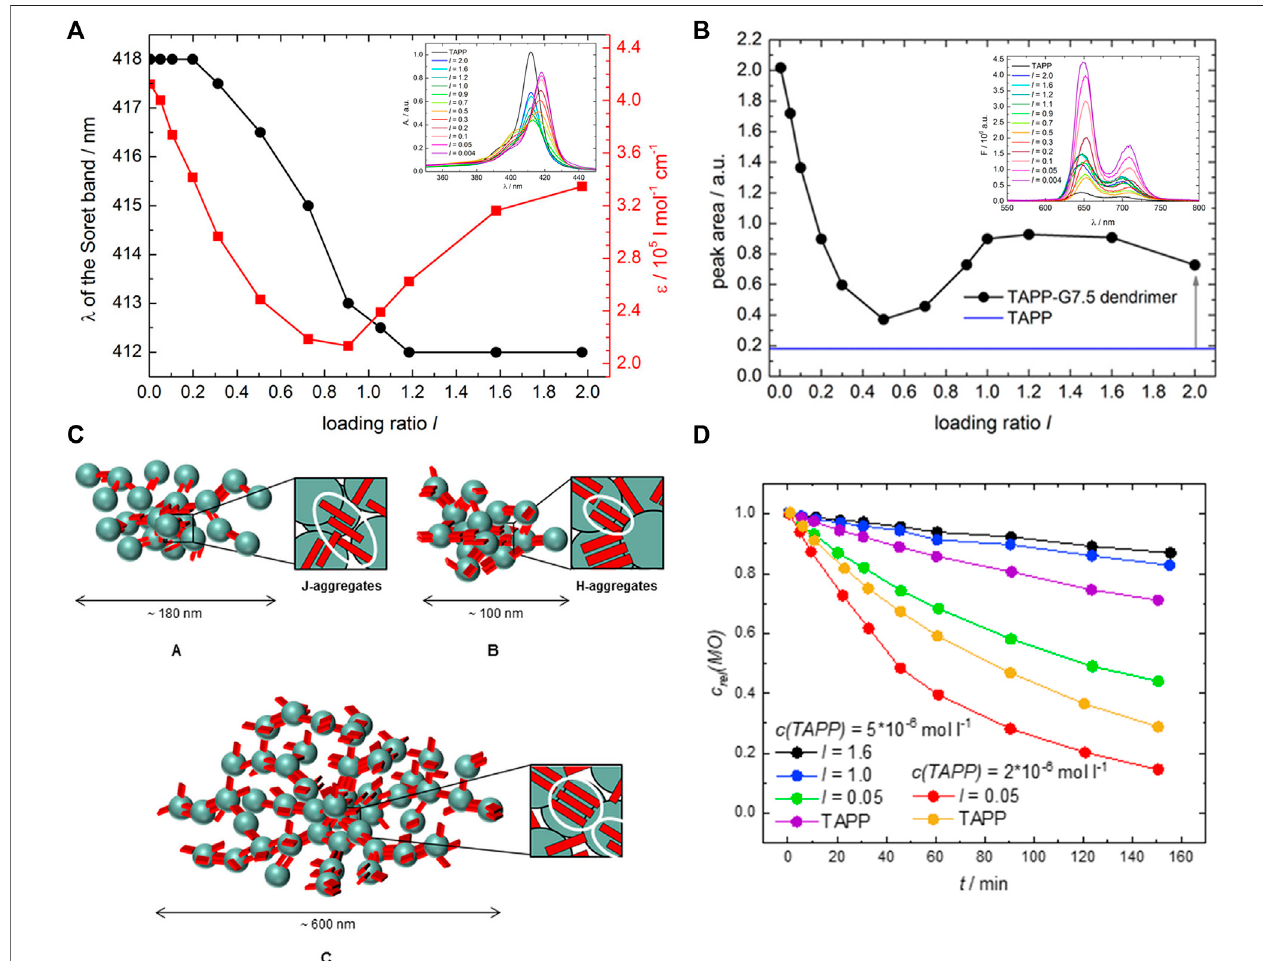
FIGURE 28 | TAPP-G4 dendrimer aggregates and the dependence of the catalytic activity on the internal stacking of the porphyrins: (A) UV/Vis analysis in dependence on the loading ratio l: shift of the Soret band and changes in the extinction coef fi cient ε of the Soret band at pH 11; inset: Soret band; (B) fl uorescence analysis in dependence on the loading ratio l: area of the fl uorescence peak at 574 nm ≤ λ ≤ 800 nm; inset: fl uorescence; (C) Schematic illustration of TAPP − G7.5 dendrimer assemblies with l (cid:1) 0.05, l (cid:1) 1.0, and l (cid:1) 1.6 (red: TAPP molecules; blue: G7.5 dendrimers); (D) photocatalytic degradation of methyl orange upon irradiation with visible light similar to the sun spectrum as a photocatalytic model reaction: Decrease of the methyl orange concentration measured at λ (cid:1) 464 nm for TAPP − G7.5 dendrimer assemblies with different loading ratios and for TAPP only (Krieger et al., 2017). Reprinted with permission. Copyright © 2017 American Chemical